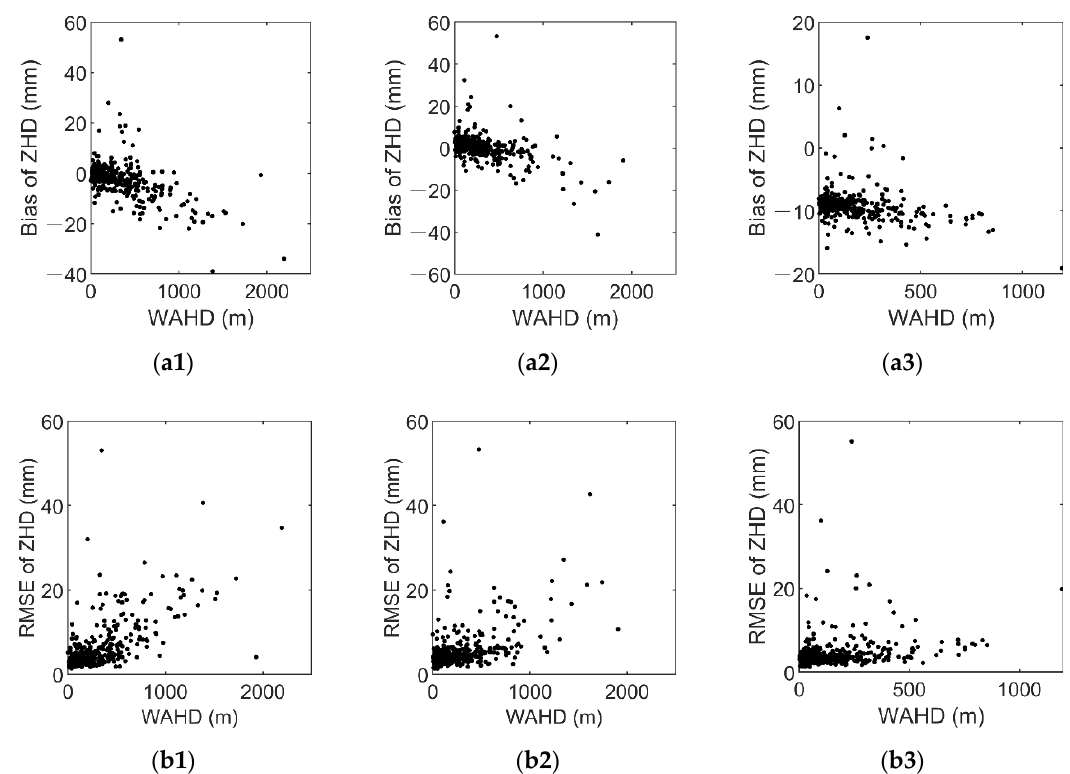
Figure 4. Correlation between the weighted absolute height difference (WAHD) and two statistics (bias and RMSE in Figure 3). ( a1 ) Bias-WAHD (VMF1_FC). ( a2 ) Bias-WAHD (VMF1_FC). ( a3 ) Bias-WAHD (VMF1_FC). ( b1 ) RMSE-WAHD (VMF1_FC). ( b2 ) RMSE-WAHD (VMF1_FC). ( b3 ) RMSE-WAHD (VMF1_FC).